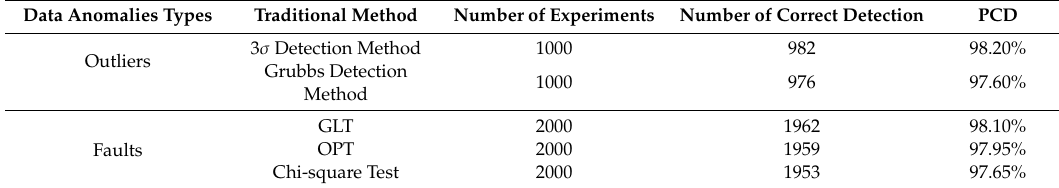
Table 8. Simulation experiment statistics of the traditional method.